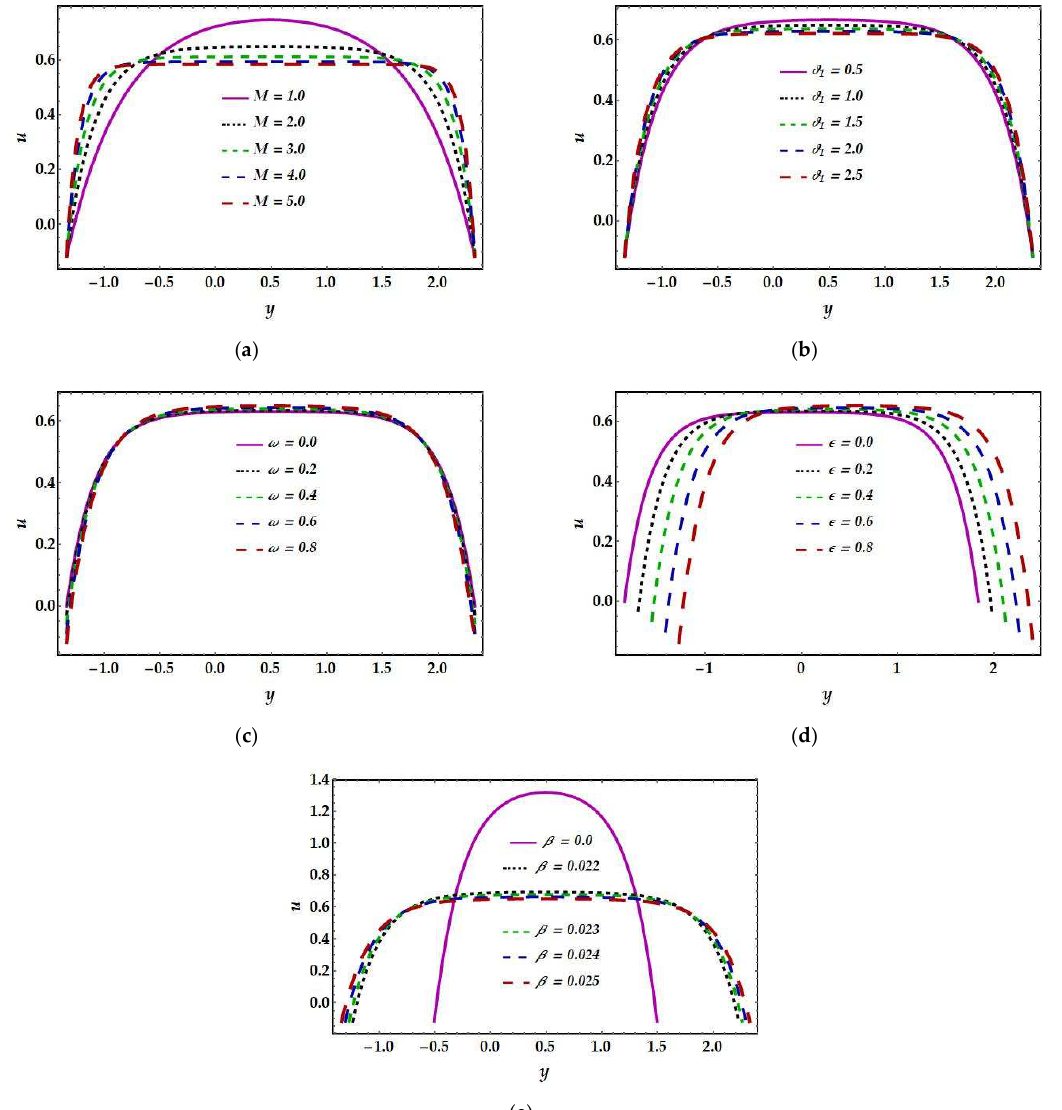
Figure 2. Effects of different physical parameters on axial velocity u